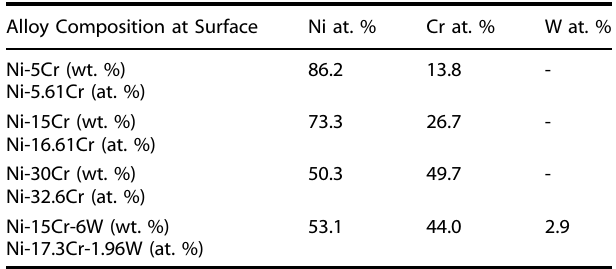
Table 1. Bulk and Surface Composition : Bulk and surface compositions for all alloys used in this study from EDS analysis (bulk), and XPS (surface and near-surface). Alloy Composition at Surface Ni at. % Cr at. % W at. %